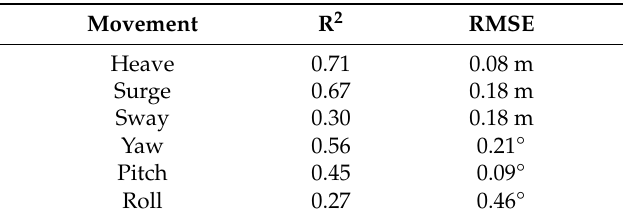
Table 9. Values of the R 2 coe ffi cient and the root mean square error (RMSE) of the calculated transfer functions. Movement R 2 RMSE